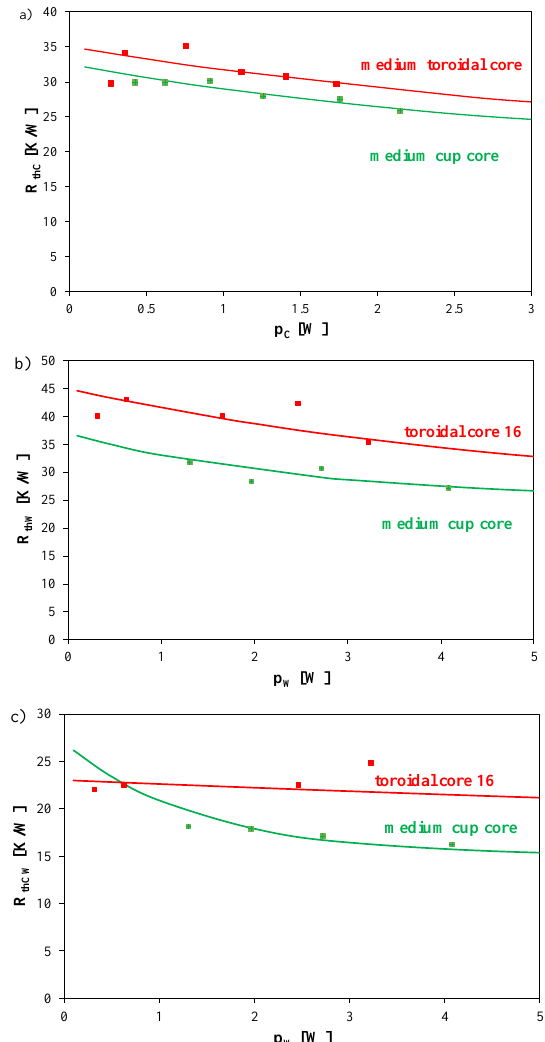
Figure 16. Measured and calculated dependences of thermal resistances ( a ) R thC , ( b ) R thW and ( c ) R thCW of inductors with the medium cup core and the toroidal core on power dissipated in the core.